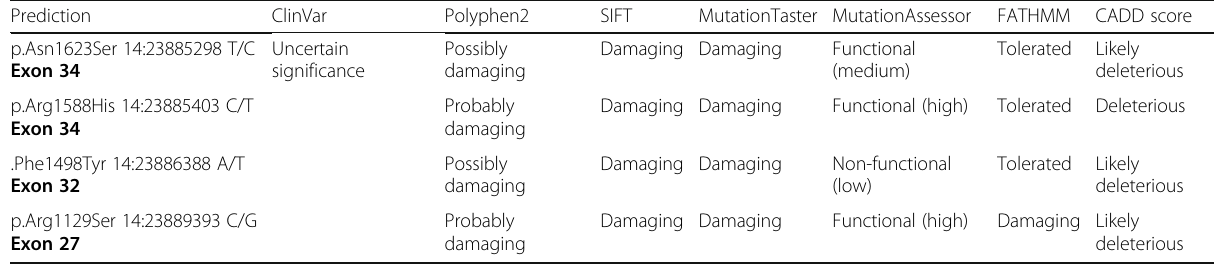
Table 3 The Predicted results of the pathogenicity assessment of four unannotated variants Prediction